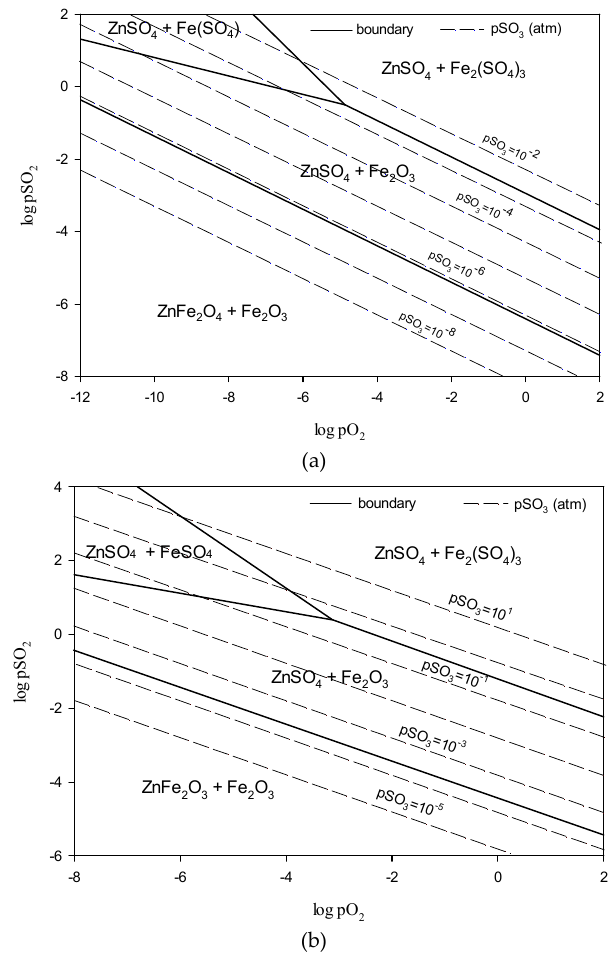
Figure 2 . ( a ) Predominance area diagram for the Fe-Zn-O-S system at 600 °C. ( b ) Predominance area Figure 2. ( a ) Predominance area diagram for the Fe-Zn-O-S system at 600 ◦ C. ( b ) Predominance area diagram for the Fe-Zn-O-S system at 700 °C. diagram for the Fe-Zn-O-S system at 700 ◦